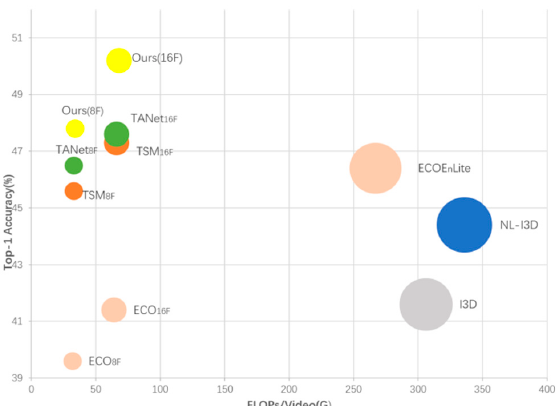
Figure 1. A comparison of performances in terms of Top 1 vs. computational cost on Something- Something V1 (note that the larger the circle the higher the computational cost).